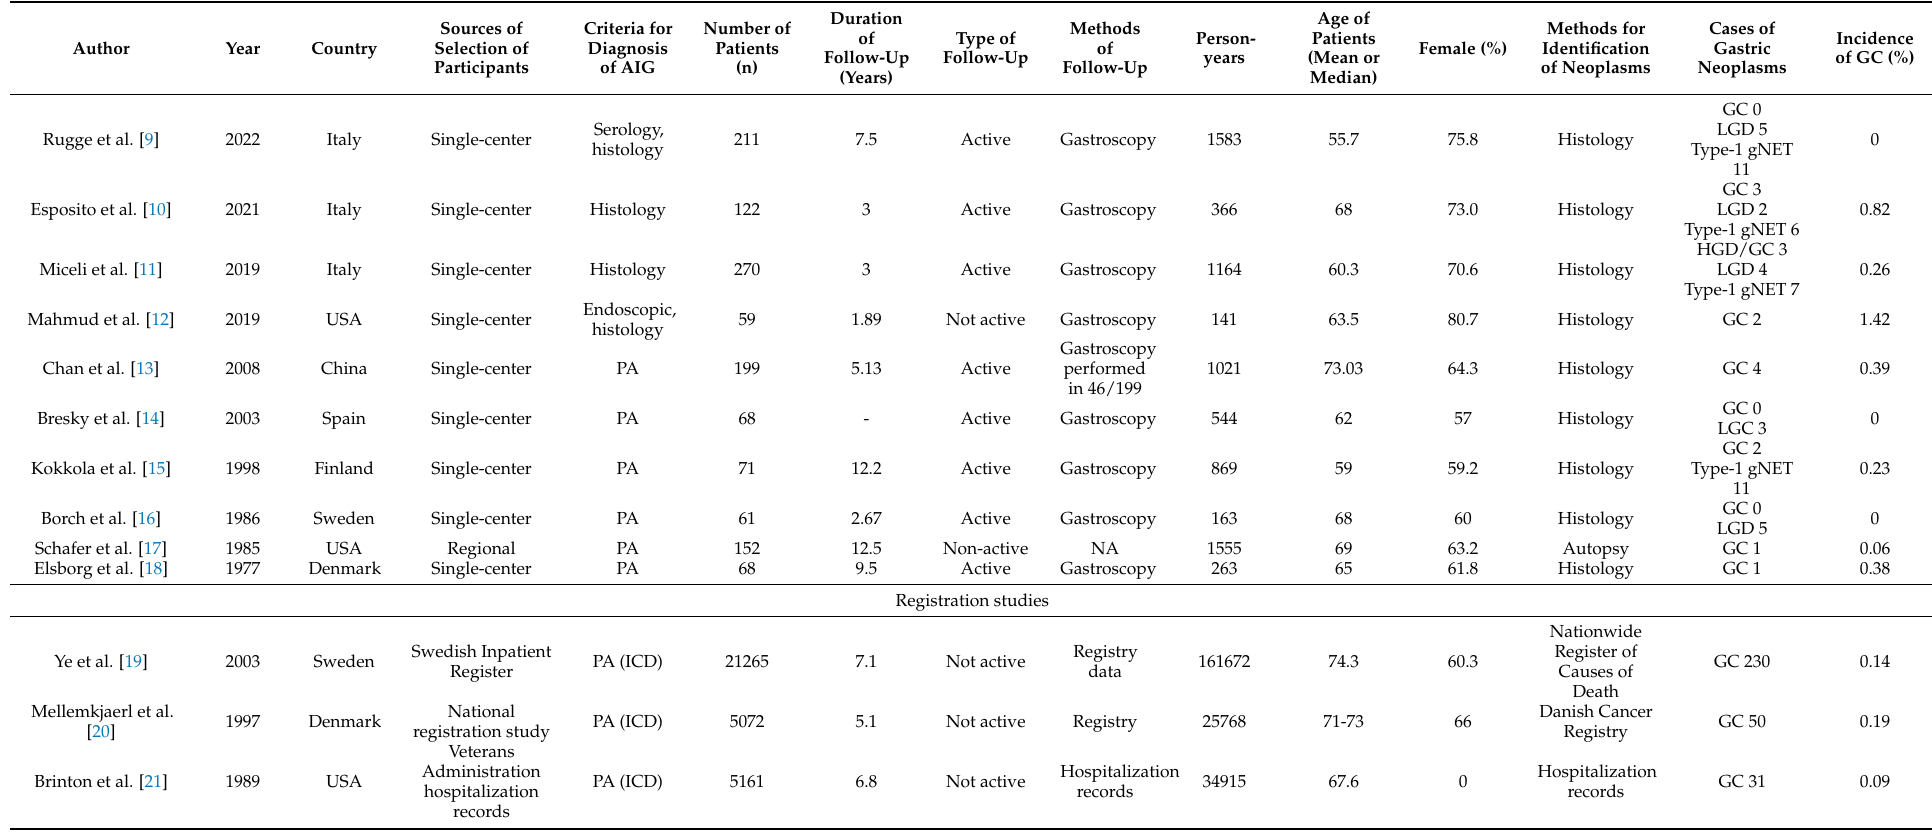
Table 1. Characteristics of Included